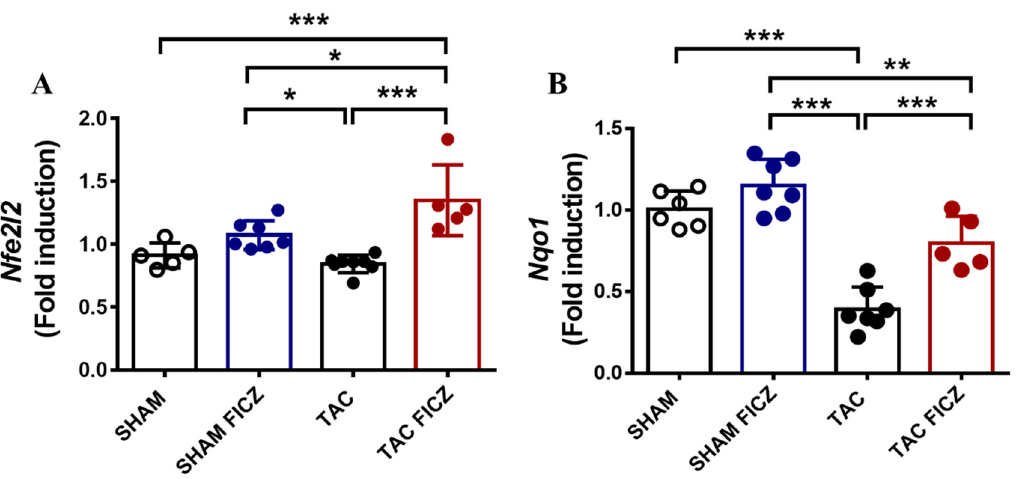
Figure 7. The antioxidant effect of FICZ on mice subjected to TAC surgery involves activation of the transcription factor nuclear factor erythroid derived 2-like 2 ( Nfe2l2 ) and the antioxidant target gene NADPH/dehydrogenase quinone 1 ( Nqo1 ). Real-time PCR analysis of Nfe2l2 ( A ) and Nqo1 ( B ), normalized to the housekeeping gene Rplp0 . Groups are: Sham (open circles) ( N = 5), Sham FICZ (blue circles) ( N = 7), TAC (black circles) ( N = 8) and TAC FICZ (red circles) ( N = 5). Data are expressed as mean ± SD. *** p < 0.001; ** p < 0.01; * p < 0.05.